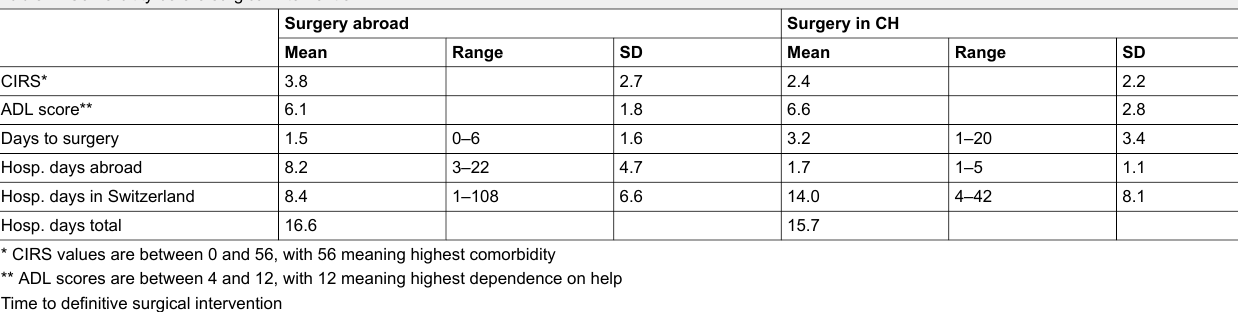
Table 4: Comorbitity before surgical intervention. Surgery abroad Surgery in CH Mean